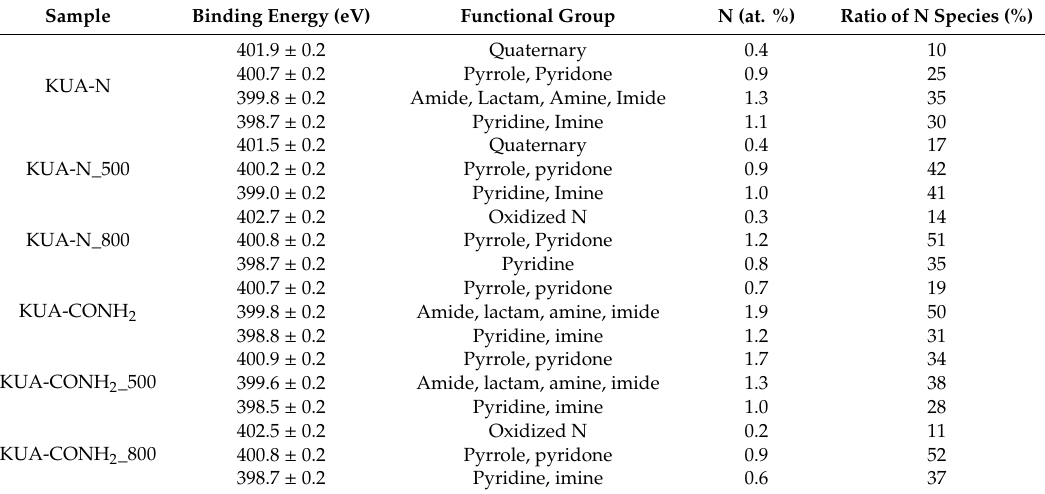
Table 3. Assignment of N1s deconvoluted curves to nitrogen functional